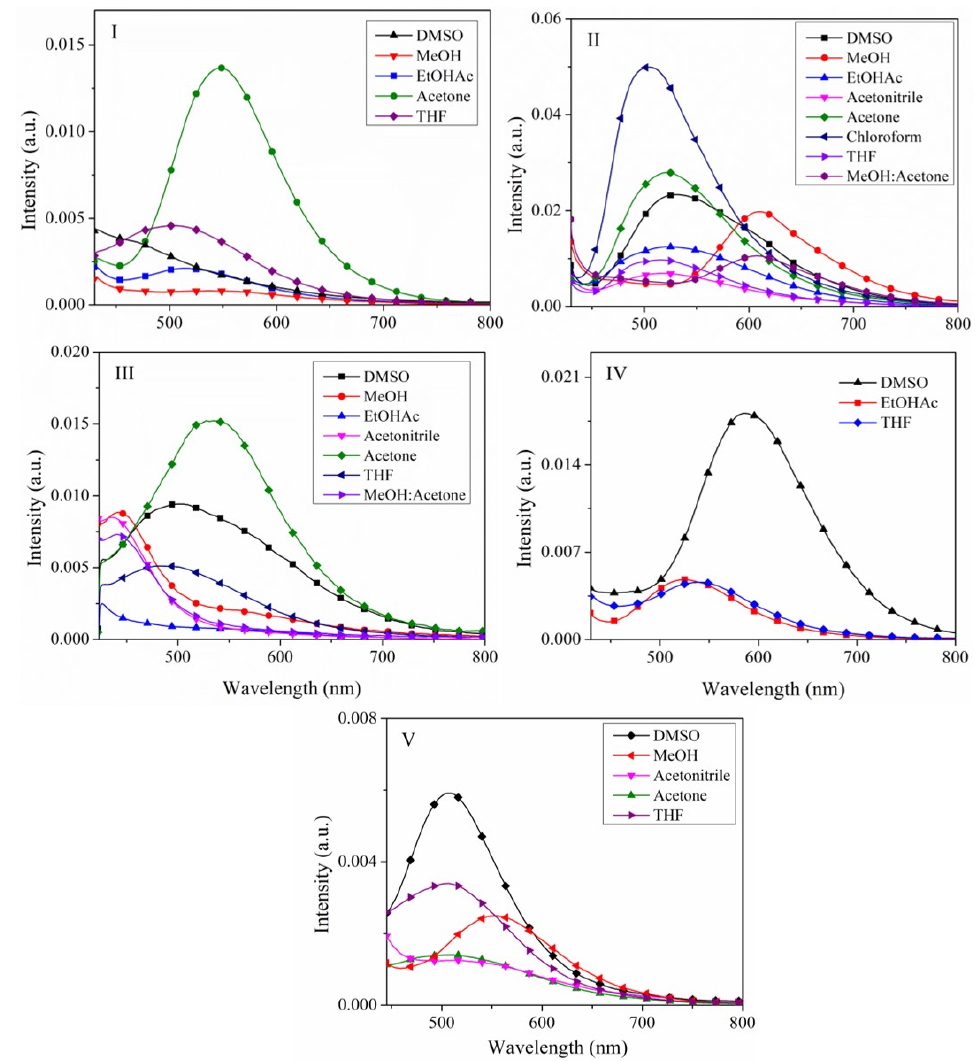
Figure 8. Emission spectra of compound I – V in solvents DMSO, MeOH, AcCN, acetone, THF, EtOAc, CHCl 3 , and MeOH:acetone (70:30). Concentration of 0.001 mM. Lippert’s equation: 03C5 ῡa − ῡf = SF (ε, n) + const. F L ( ε , n) [polarity function of Lippert’s equation]: (cid:1832) (cid:3013) (ε, n) = F(ε, n) = (cid:4680) (cid:2013) − 1 2(cid:2013) + 1 − (cid:1866) (cid:2870) − 1 2(cid:1866) (cid:2870) + 1(cid:4681)